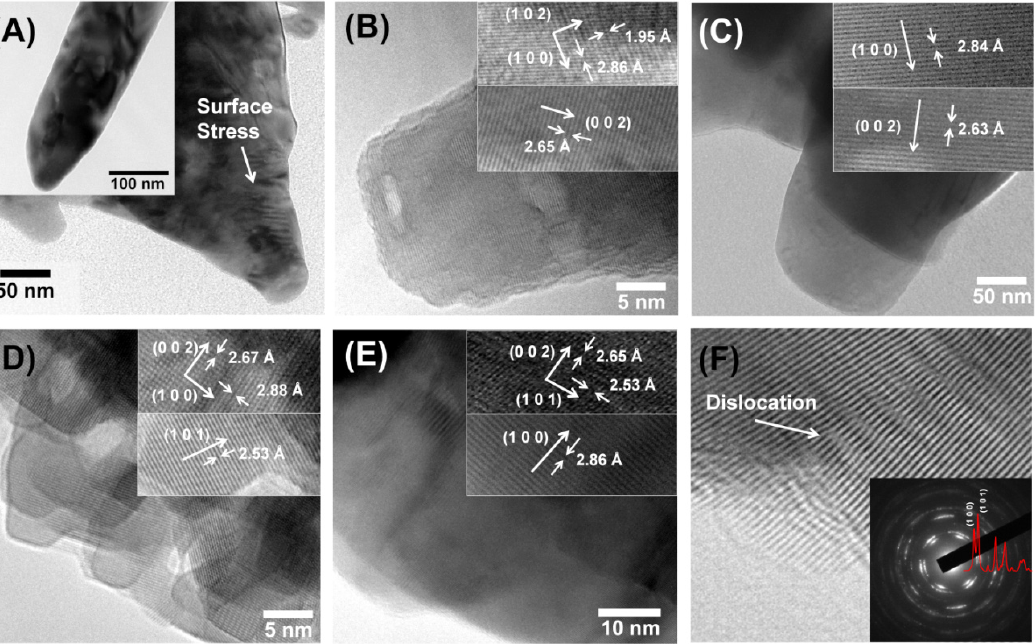
Figure 6: (A) Surface stress on ZnO NFs after annealing. HRTEM of (B) unannealed and (C) annealed ZnO NFs with the change of (1 0 0), (0 0 2) and (1 0 1) lattice spacing depicted in the inset. HRTEM of (D) unannealed and (E) annealed ZnO SPs with the change of (1 0 0) and (0 0 2) lattice spacing is depicted in the inset. The annealing treatment was conducted at 400 o C. Similar structural behavior is observed for ZnO NRs (Fig. S7 in Supporting Information). (F) A small angle grain boundary by coalescence of ZnO SPs upon annealing and the inset selected area electron diffraction (SAED) pattern indicating a crystallographic texture of the corresponding ZnO